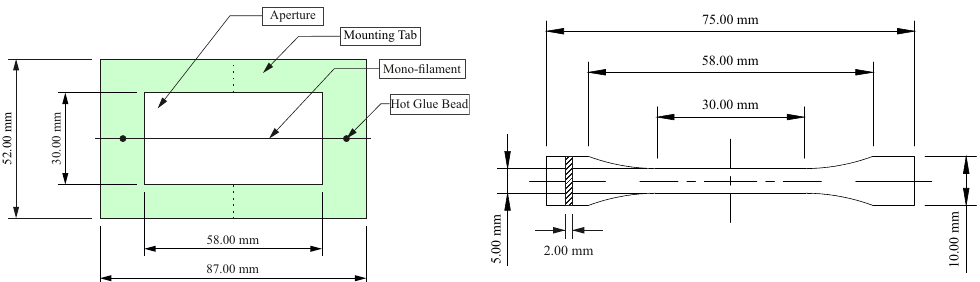
Figure 2. Representation of the mounting tab for single-filament tensile tests (According to [38]— left ) and technical specifications for the ISO 527-02 Type 1BA dumbbell tensile test specimen (According to [39]— right